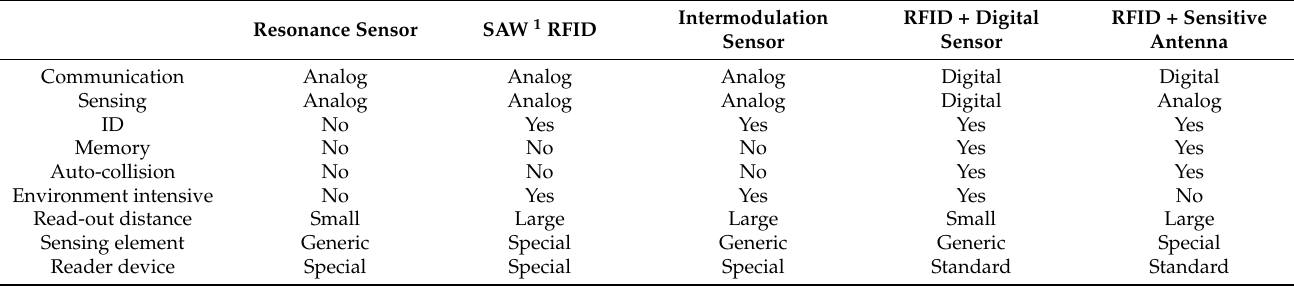
Table 1. Comparison of the passive wireless sensors features